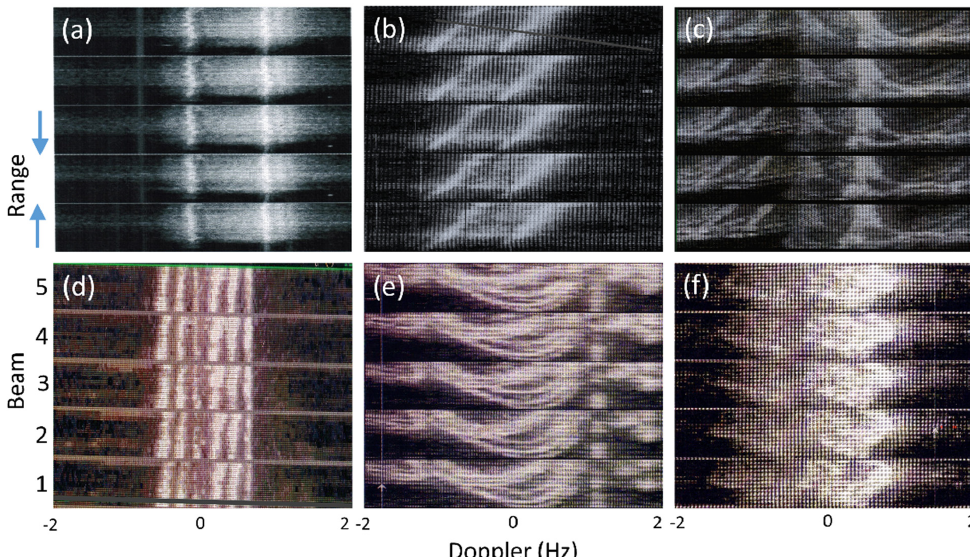
Figure 23. Azimuth-range-Doppler maps for different propagation conditions, showing the variety that signal processing must deal with. ( a ) ideal propagation, ( b ) range-dependent Doppler shift, ( c ) multiple modes with range-dependent Doppler and leading-edge effects, ( d ) E-E, E-F and F-F modes with mode-dependent Doppler shift, ( e ) leading edge of F-mode seen via E-F and F-F, with magnetoionic splitting and traces of E—E mode, ( f ) diffuse multimode with travelling ionospheric disturbance. As a final example of the kind of data that can yield to the analysis, Figure 24 shows a range-Doppler map with a clear land-sea boundary roughly halfway through the range bracket, along with echoes from a cluster of small islands. There is obvious broadening in Doppler, along with possible unresolved multimode and a range-dependent Doppler shift. The echoes are strong from beams 5–10 but become progressively weaker in the lower beams. Rather poor quality, it might seem, but this coastline lies at a range of over 8000 km. Together, the coastline and island echoes enabled geographic registration in both range and azimuth to within 20 km; without them, the position error exceeded 200 km in both dimensions. Moreover, the broadened first-order echoes easily support the estima- Doppler spectra with no remedial steps, as used in Figure 21.